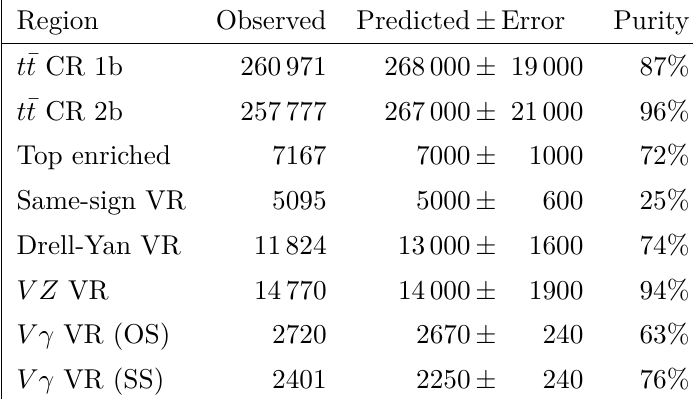
Table 3 . Summary of the observed and predicted events in the background control regions (CR) and validation regions (VR), and in the top-background enriched selection. The uncertainty in the prediction includes statistical and systematic effects, excluding theory uncertainties on the signal. The purity column gives the purity of the target process, relative to the total prediction. The t ¯ t prediction in the two t ¯ t control regions is from simulation, while in the top-enriched region the data-driven estimate is used.